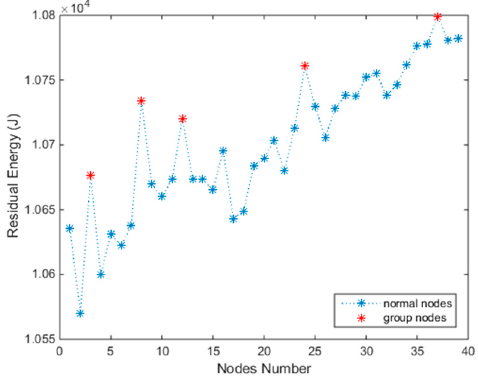
Figure 4. Residual energy of all nodes at balanced state.